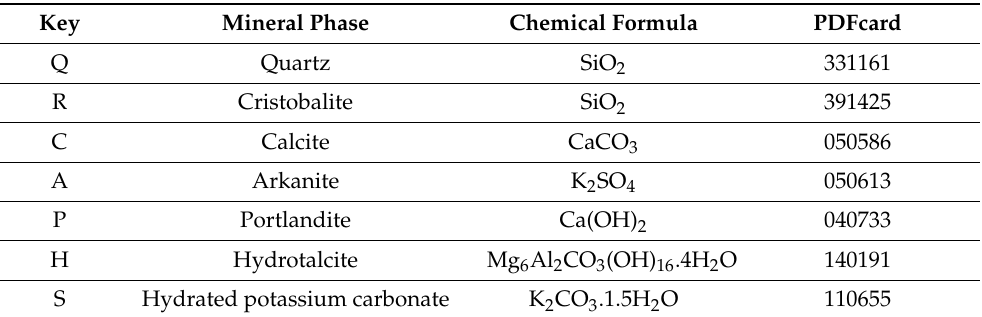
Table 4. XRD characterization: name of minerals, PDF card of phases and chemical formula of phases presented in CH/RSA and CH/RSAW pastes.